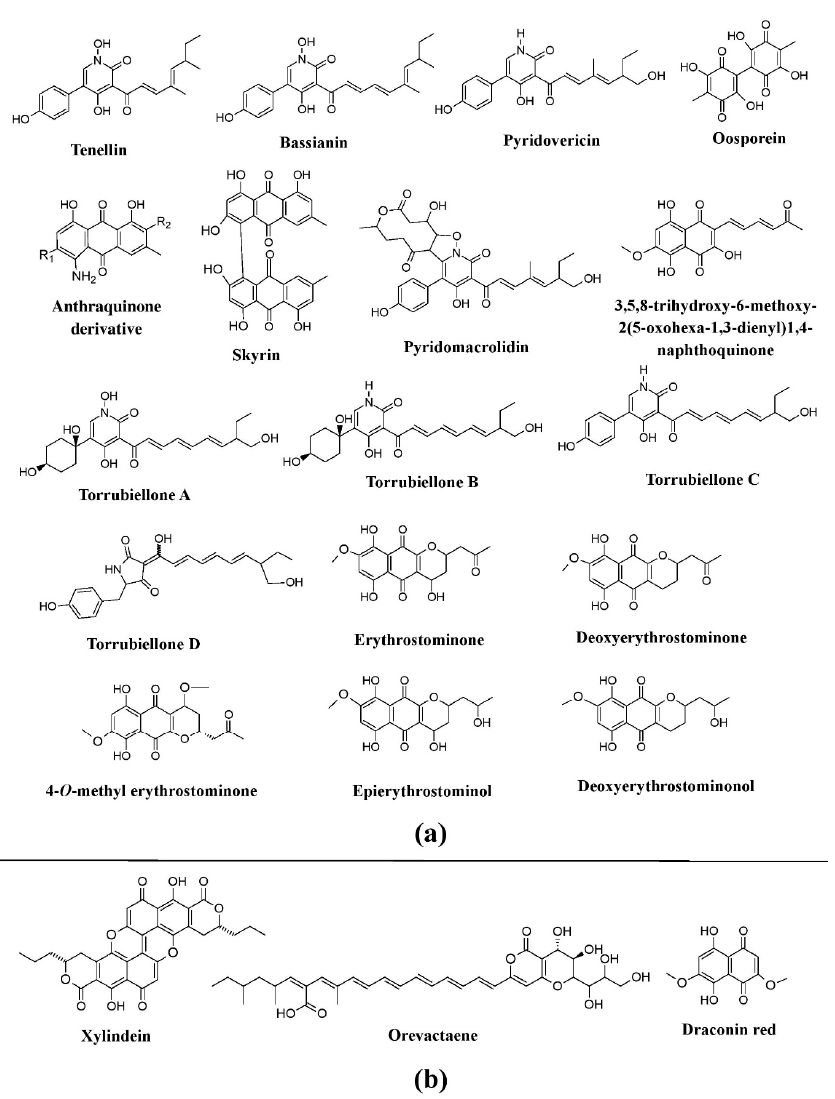
Figure 9. Pigments from the fungi of the Cordycipitaceae family and some other group. ( a ) Pigments from members of the families Cordycipitaceae (species of Beauveria , Torrubiella , Cordyceps , Hyperdermium , and Lecanicillium ) and Ophiocordycipitaceae ( Ophiocordyceps sp.), re-drawn from [25,41,73–75,125]. ( b ) Pigments known from other groups of fungi (species of Chlorociboria , Scytalidium, and Epicoccum ), re-drawn from [37,41].